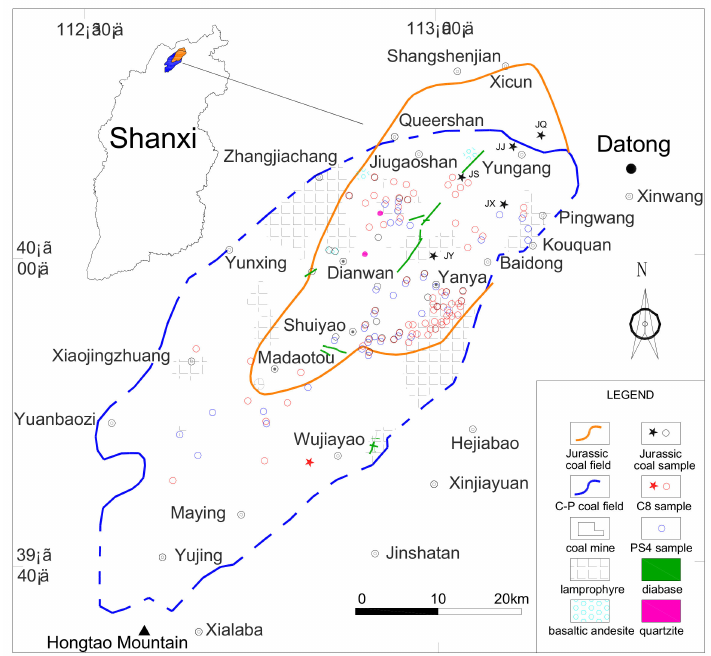
Figure 3. The sample location and igneous rock distribution of the Datong